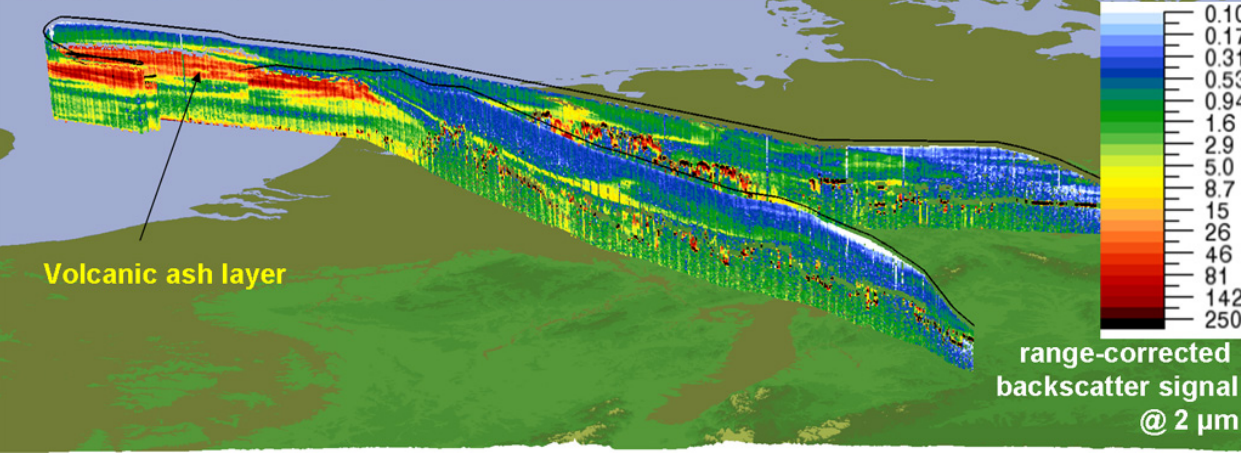
Fig. 16. Lidar cross-section of range corrected backscatter signal along the flight path from Leipzig (Germany) to the North Sea and back to Oberpfaffenhofen near Munich (Germany) in the afternoon of 17 May 2010. The volcanic ash layers over the North Sea are indicated by red and yellow colors. The flight altitude above the North Sea was